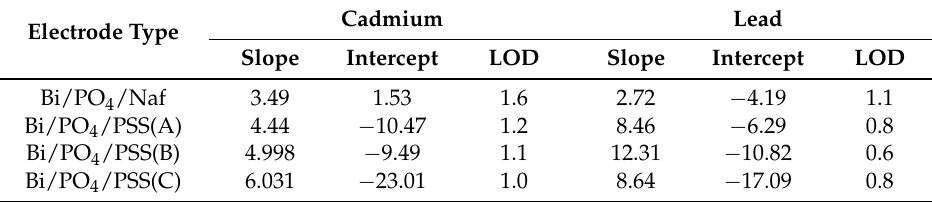
Table 3. Comparison of the linear calibration best fit parameters for cadmium and lead analysis as a function of the method used for bismuth film preparation. Experimental conditions: pH = 2; [Cd 2+